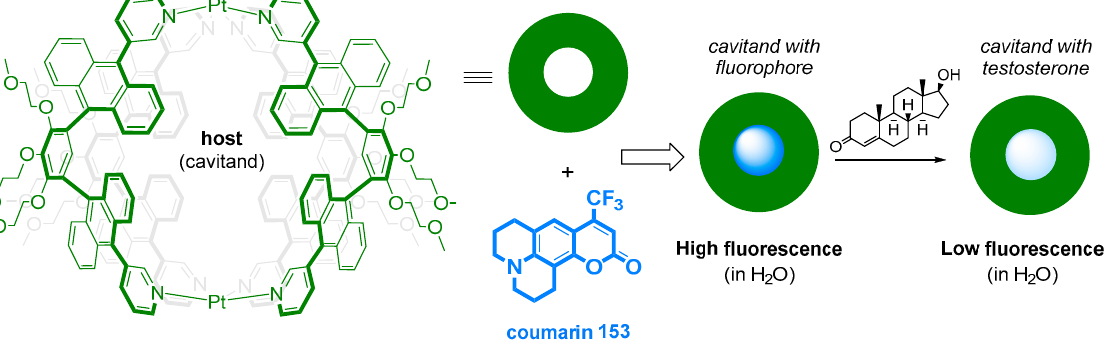
Figure 11. A diagram showing the molecular structure of the host (in green) and guests (coumarin 153 in blue, testosterone) used in the nanogram-scale fluorescent detection of testosterone. The fluorescent cavitand had the emission at λ = 423 nm (using λ ex = 356 nm) [128].